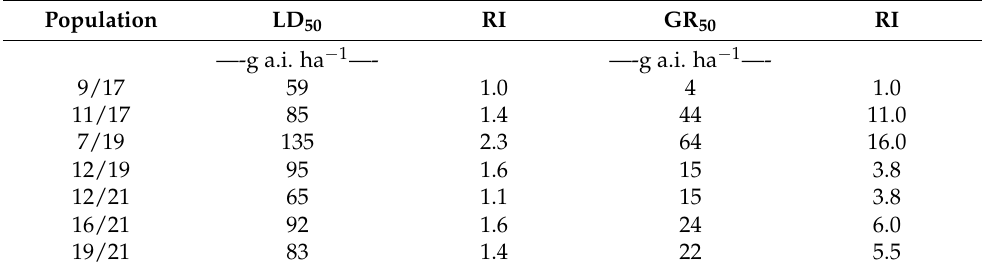
Table 3. Estimated imazapic doses to kill 50% of the plants (LD 50 ) of seven populations of Chloris virgata , imazapic doses required to reduce plant biomass by 50% (GR 50 ), and resistance indices (RI).